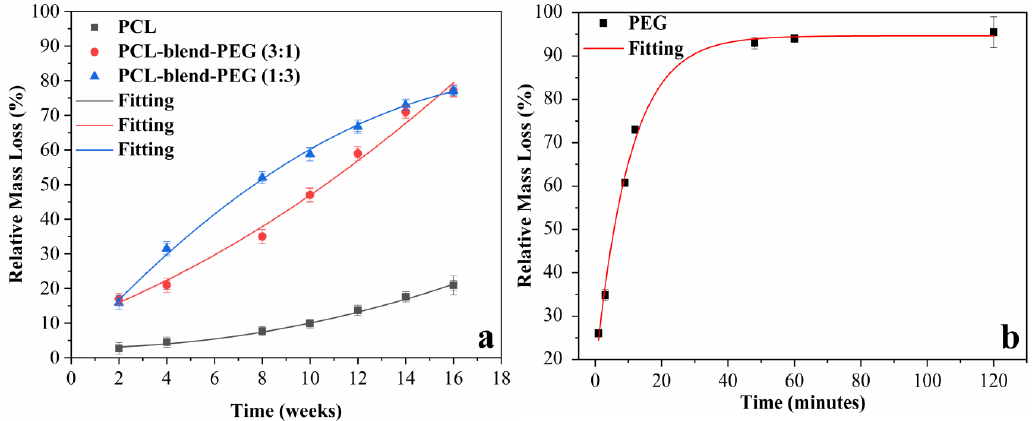
Figure 6. Relative mass loss curves illustrating the degradation behavior of polymeric coatings occurring during dynamic testing in SBF at 37 °C. The corresponding degradation time is 16 weeks for: simple PCL; PCL-blend-PEG (3:1), PCL-blend-PEG (1:3) coatings ( a ), and 120 minutes for simple PEG coatings ( b ), respectively.